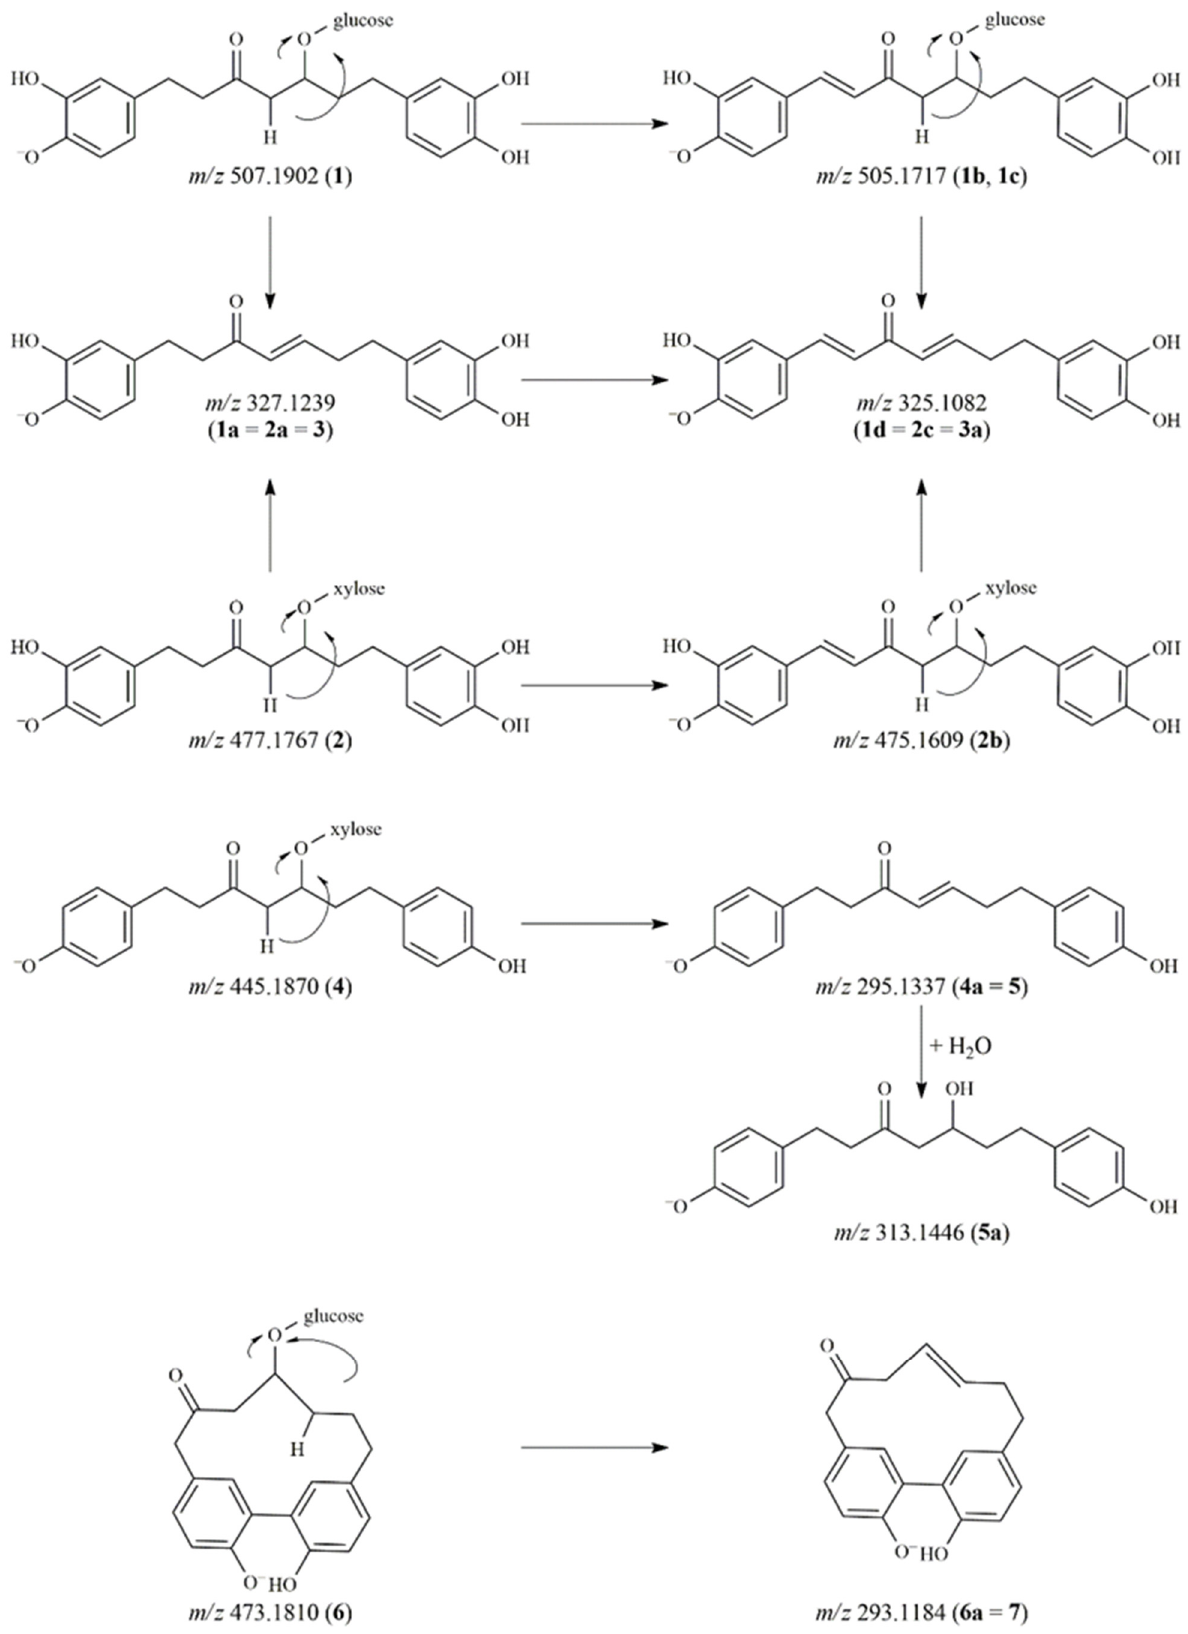
Figure 1. Proposed degradation pathways of diarylheptanoids.